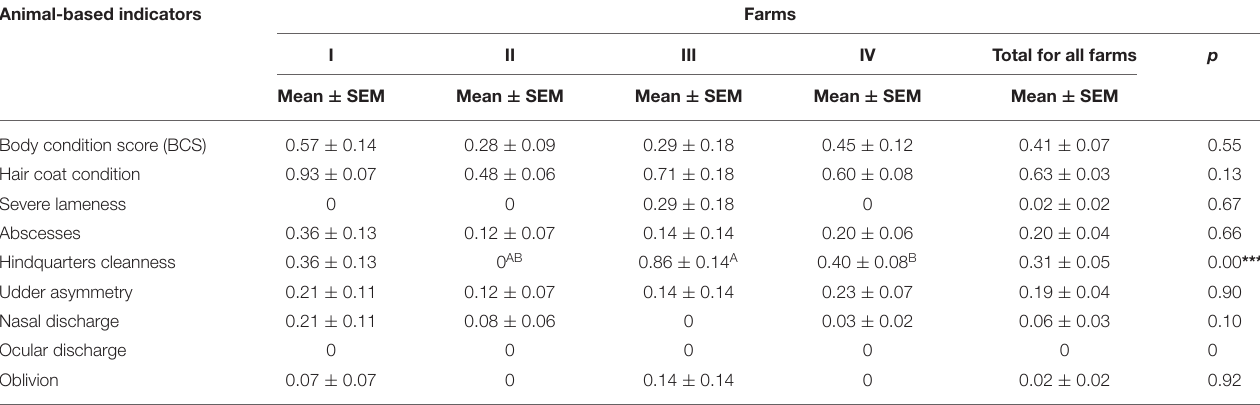
TABLE 3 | Mean ( ± SEM) scores for animal-based welfare parameters in goats examined in four farms in Serbia. Animal-based